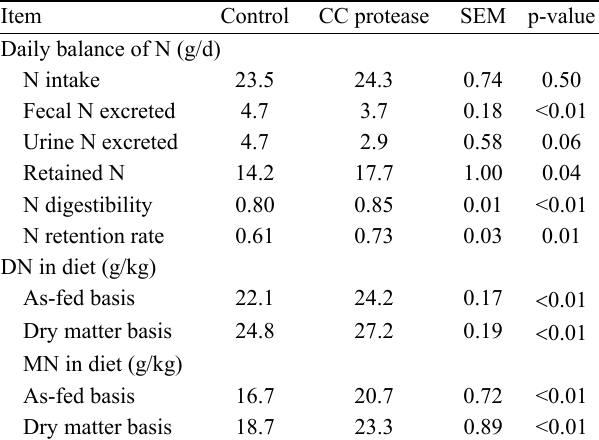
Table 3. Daily balance of nitrogen (N) and concentration of digestible and metabolizable nitrogen (DN and MN) in basal diet or diet with 0.2 g/kg proteases for pigs (Exp. 1)